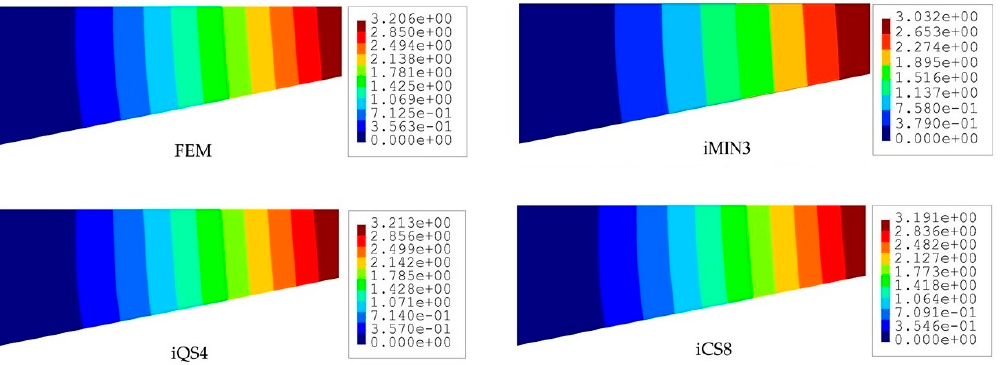
Figure 4. Contours of total displacement [mm] for the tapered plate.